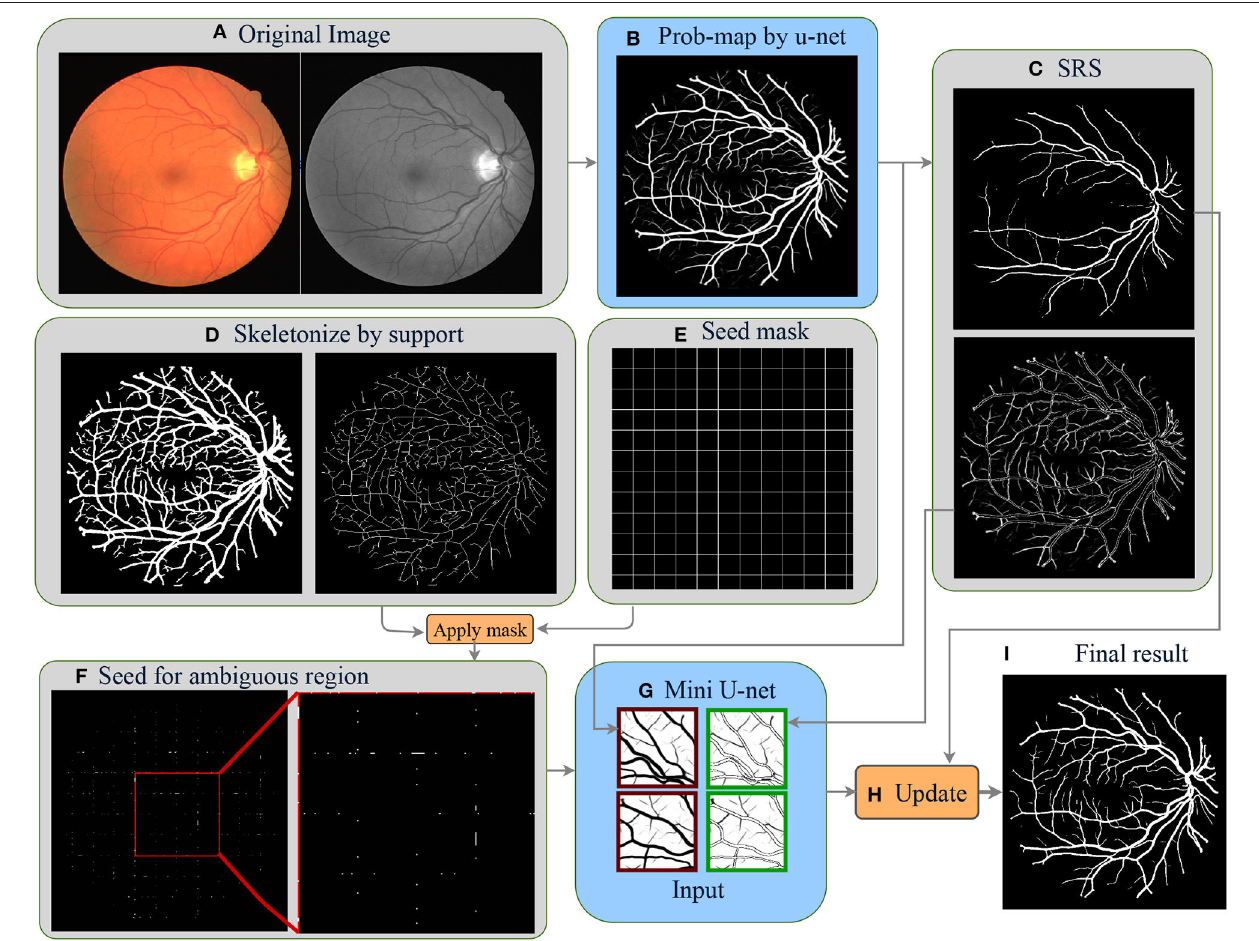
FIGURE 1 | Dynamic Vessel Segmentation Pipeline: We separate vessel segmentation into simpler tasks. The steps in gray boxes are fixed, while the ones in blue require training. In (A) , we first extract the green channel and preprocess it with contrast adaptive histogram equalization. Then, in (B) we train a U-net architecture using a dynamic loss function. This network outputs a likelihood map across the entire image. In (C) , we use two thresholds, support and resistance , (SRS) to separate easy (top image) from ambiguous (bottom image) pixels. We assign the final labels to easy pixels at this stage. To classify ambiguous pixels, in (D) we use the support threshold to generate a high-recall estimate of the vascular structure (left image) and then skeletonize this mask (right image). We then intersect this skeleton with a lattice mask (shown in E ) to find a set of seed points (shown in F ). The left image in (F) shows the seed locations for the entire image, while the right image is a close-up of the square shown in red. We then define a small patch around each seed point and train a small network ( mini-U-net ) on these patches (G) . Each patch has two channels. The channel highlighted with the purple border is extracted from the original likelihood map, while the channel with the green border includes only the ambiguous pixels in that region. In (H) , we merge the mini-U-net predictions for ambiguous pixels with the labels for the easy pixels to obtain our complete segmentation result (shown in I ). Figure best viewed on-screen.